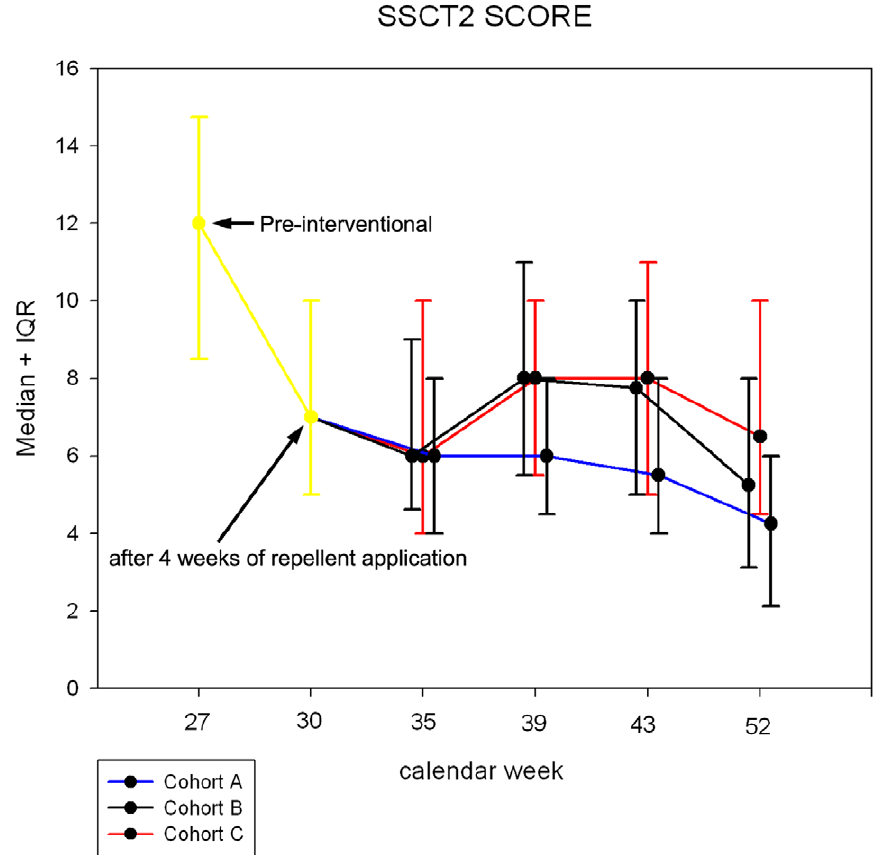
Figure 6. SSCT-Score during the study period. During the first round of application of Zanzarin (twice daily for 4 weeks) the SSCT decreased in an identical manner in the three cohorts. For sake of clarity the data points of cohort B and C were shifted + / 2 0.1 calendar weeks on the x-axis, although the assessment of the SSCT was done simultaneously in the three cohorts.